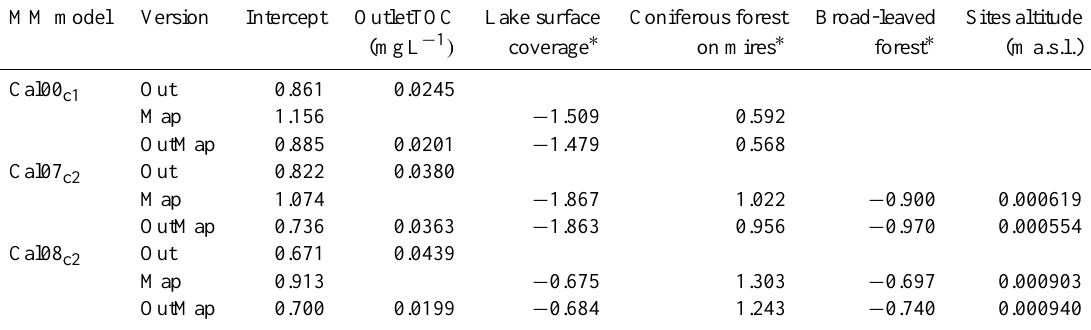
Table 4. Coefficients for the best-fit hierarchical linear mixed models (MM), where Log 10 (TOC HW ) is the response variable. See the Method section for more